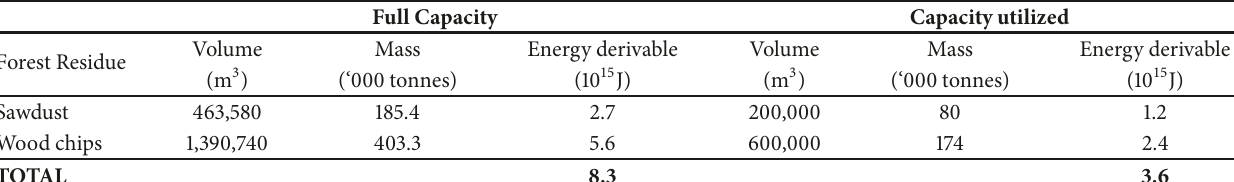
Table 3: Energy potential of foreign residues in Nigeria (1997).